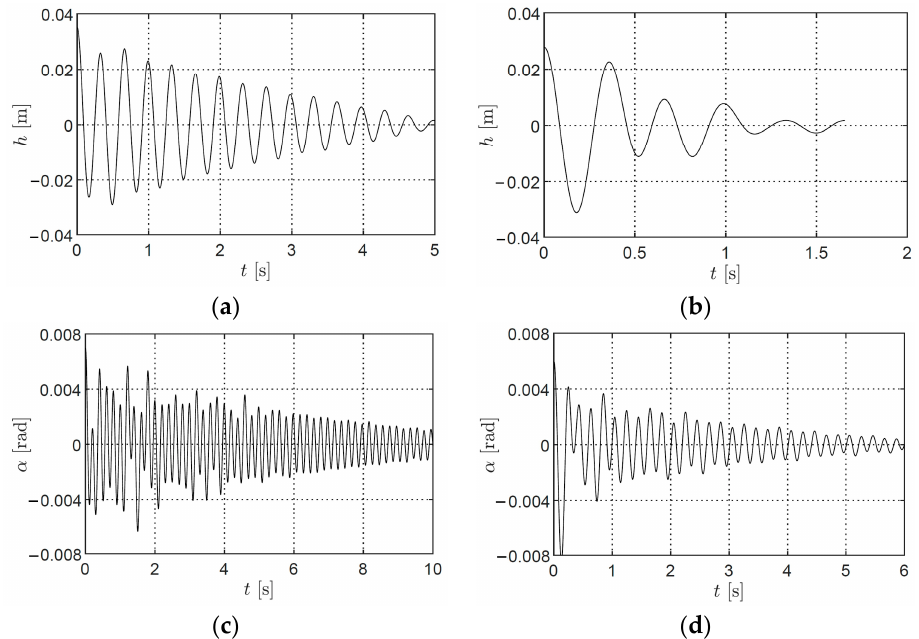
Figure 19. Vertical-dominant coupled responses from Setup 1: ( a ) vertical displacement at U = 0 m/s; ( b ) vertical displacement at U = 10 m/s; ( c ) torsional displacement at U = 0 m/s; ( d ) torsional displacement at U = 10 m/s.